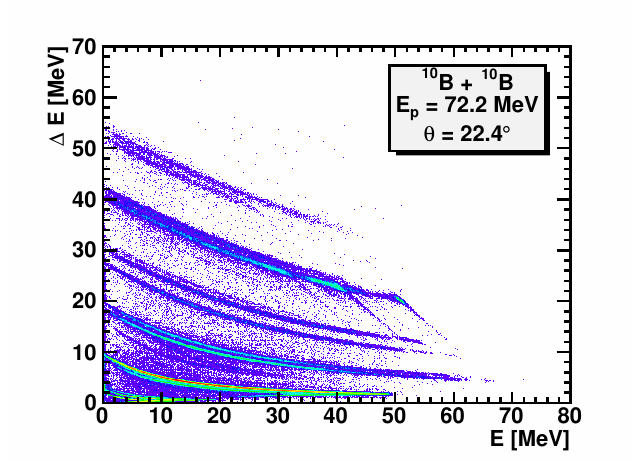
Figure 1: ∆ E-E spectrum for the 10 B + 10 B nuclear reaction measured at 72.2